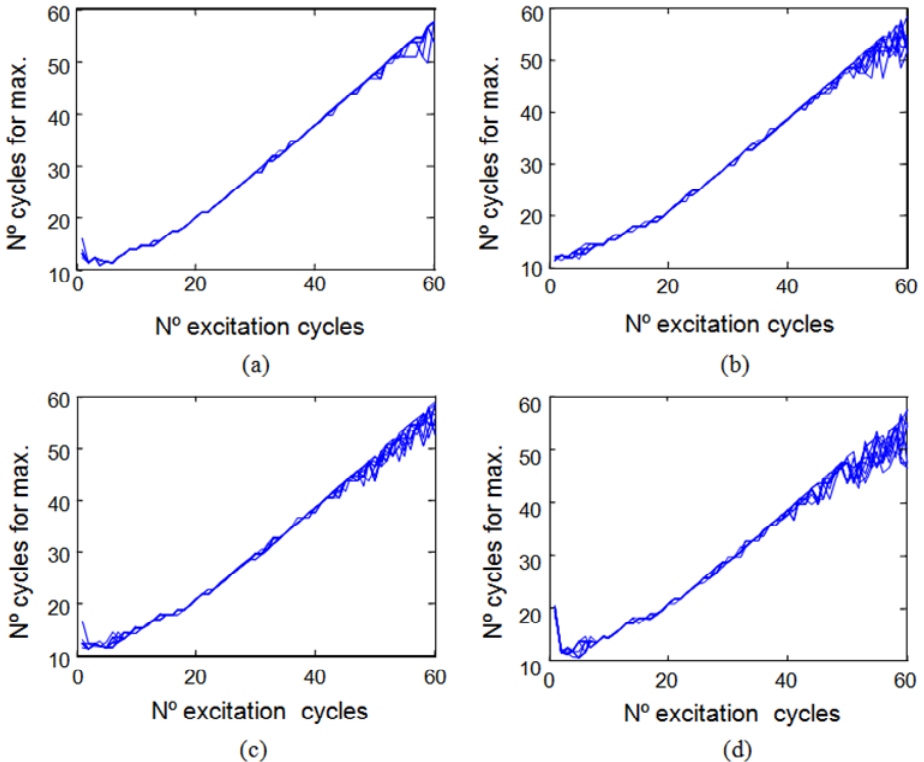
Figure 7. Excitation cycles versus cycles for maximum ( a ) transmitter and receiver facing; ( b ) Direct normal rebound; ( c ) Ten-degree-inclination wall rebound; ( d ) Twenty-degree inclination wall